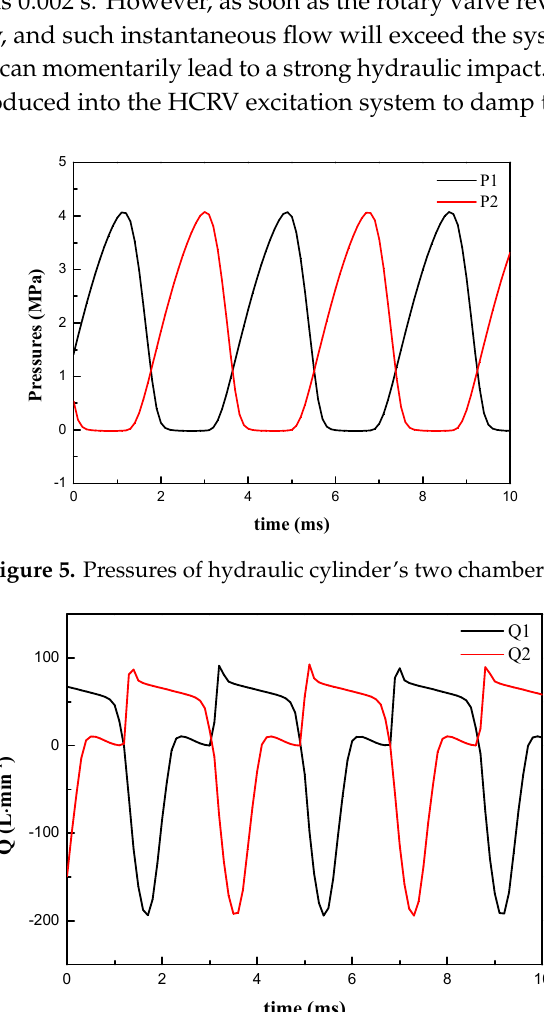
Figure 6. Flows of hydraulic cylinder’s two chambers.